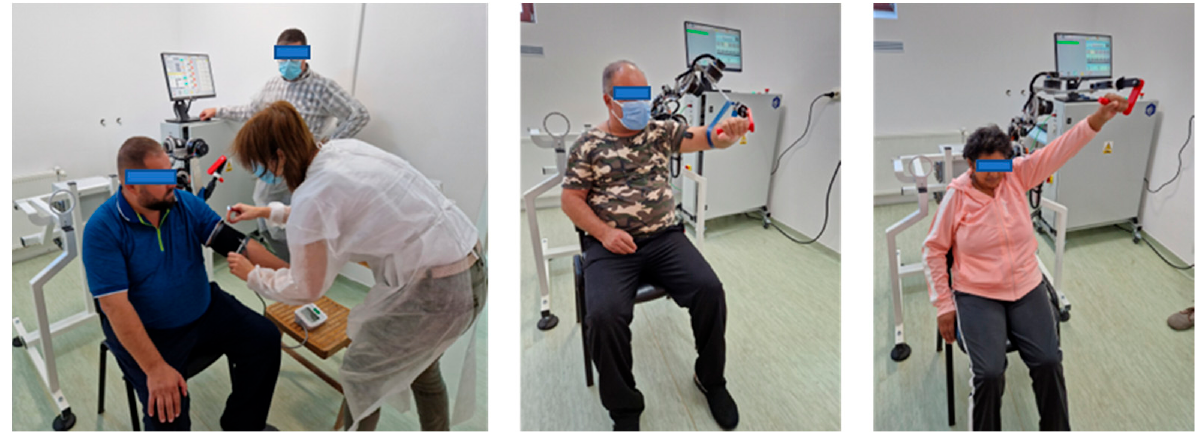
Figure 13. CardioVR-ReTone robotic exoskeleton prototype tested in a medical environment.